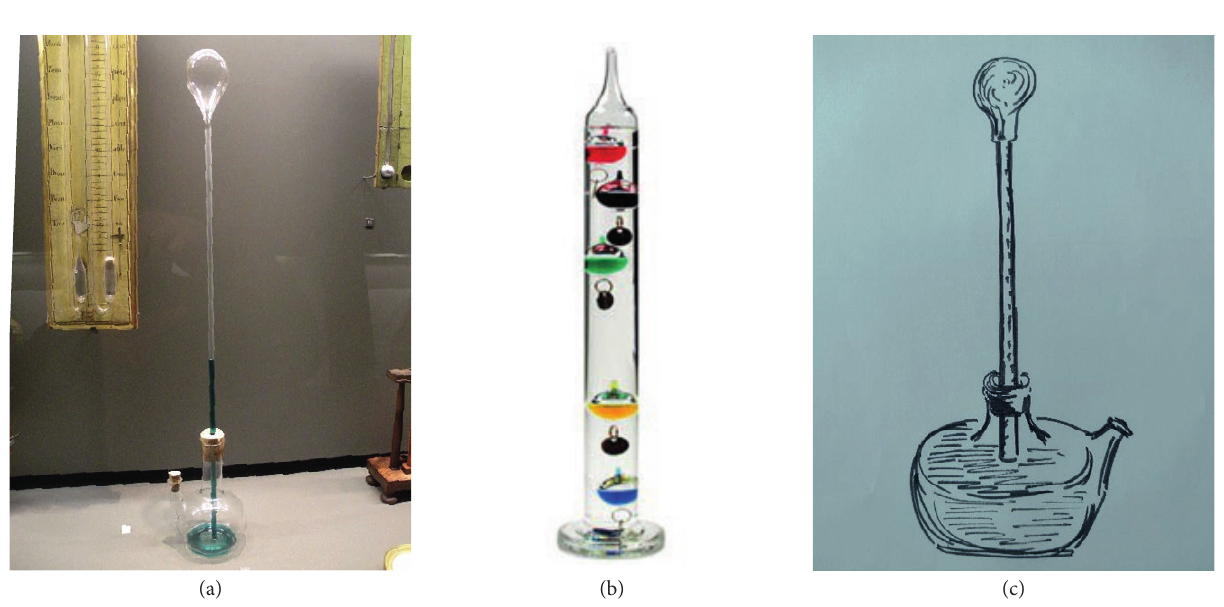
Figure 4. Some of the thermoscopes and thermometers as object of the investigation and educational activities planned by the students. (a) An historical thermoscope similar to the ones contained in the collection of the science museum ‘Galileo’ (photo credit: Wikipedia: https:// commons.wikimedia.org/); 55-57,62 (b) An example of a modern and commercial version of the so-called ‘Galilei’s thermometer’ (photo credit: Wikipedia: https://commons.wikimedia.org/); 46,47 (c) draw of a thermoscope made by a student during the educational